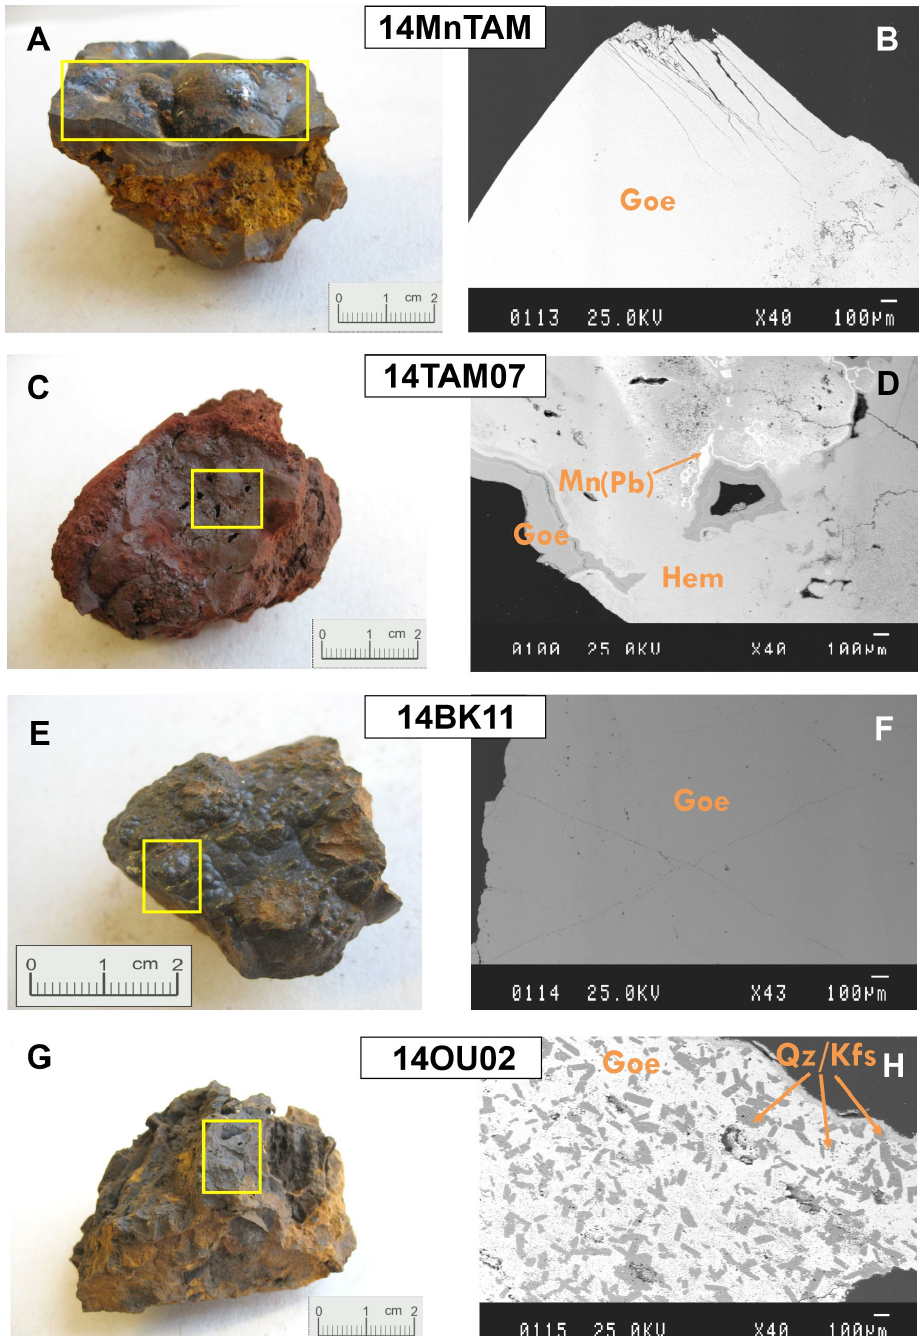
Figure 3. Samples of studied goethite and SEM microphotograph in back-scattered electrons mode, showing the pure character of supergene goethite of the samples 14MnTAM and 14BK11. Goe = goethite; Hem = hematite; Qz = quartz; Kfs = K-feldspar. ( A ) sample 14MnTAM, ( B ) SEM microphotograph in back-scattered electrons mode of sample 14MnTAM, ( C ) sample 14TAM07, ( D ) SEM microphotograph in back-scattered electrons mode of sample 14TAM07, ( E ) sam- ple14BK11, ( F ) SEM microphotograph in back-scattered electrons mode of sample 14BK11, ( G ) sample 14OU02, ( H ) SEM microphotograph in back-scattered electrons mode of sample 14OU02.